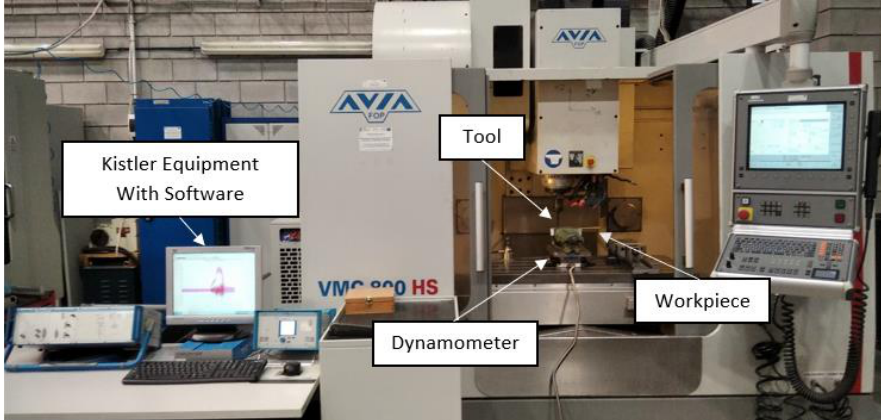
Figure 6. Test stand for measuring cutting forces.